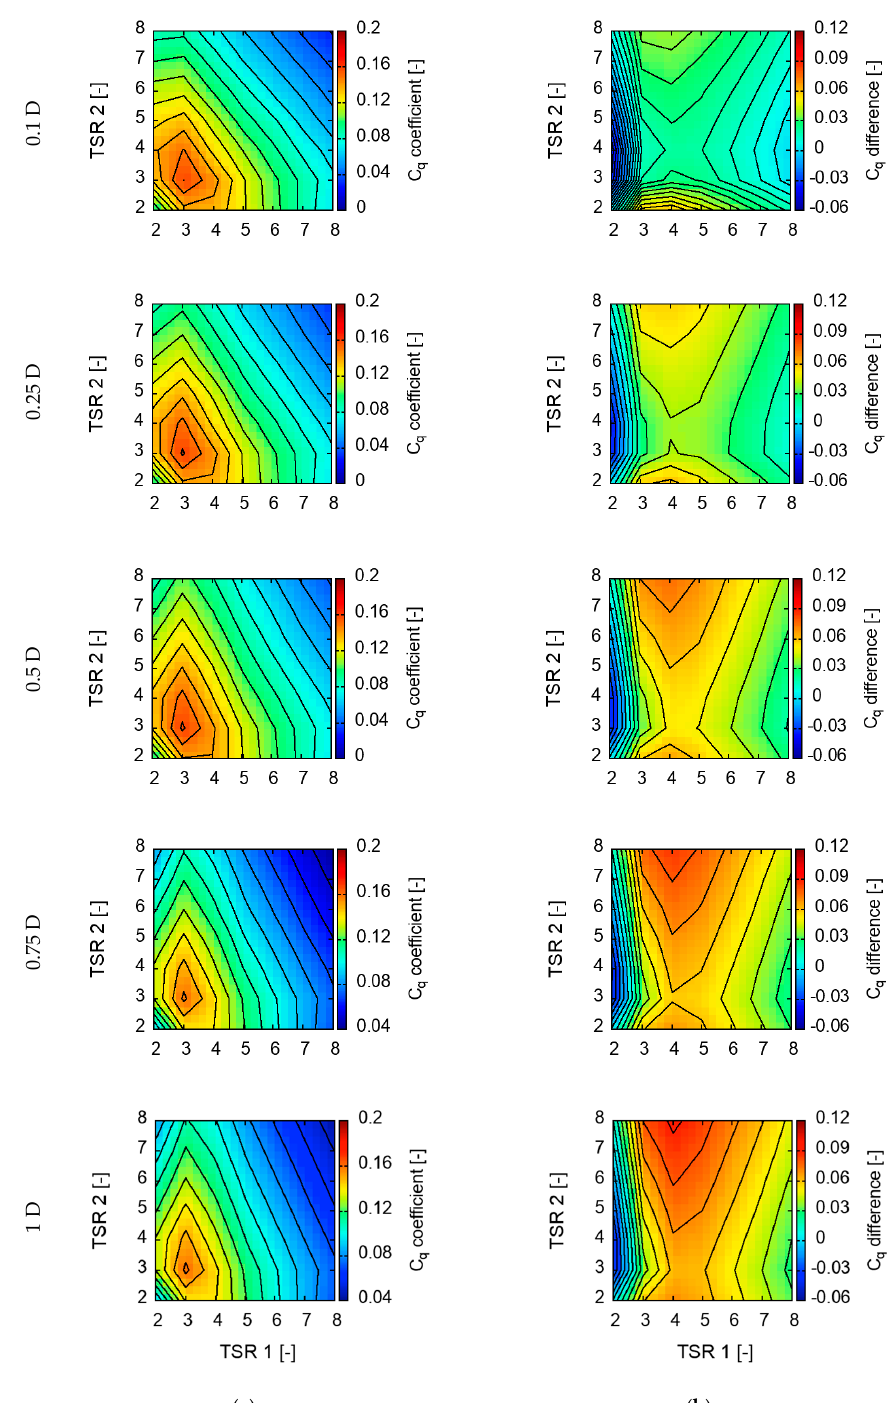
ffi cient C ff erence in C q ( a ) and the di q between rotors ( b